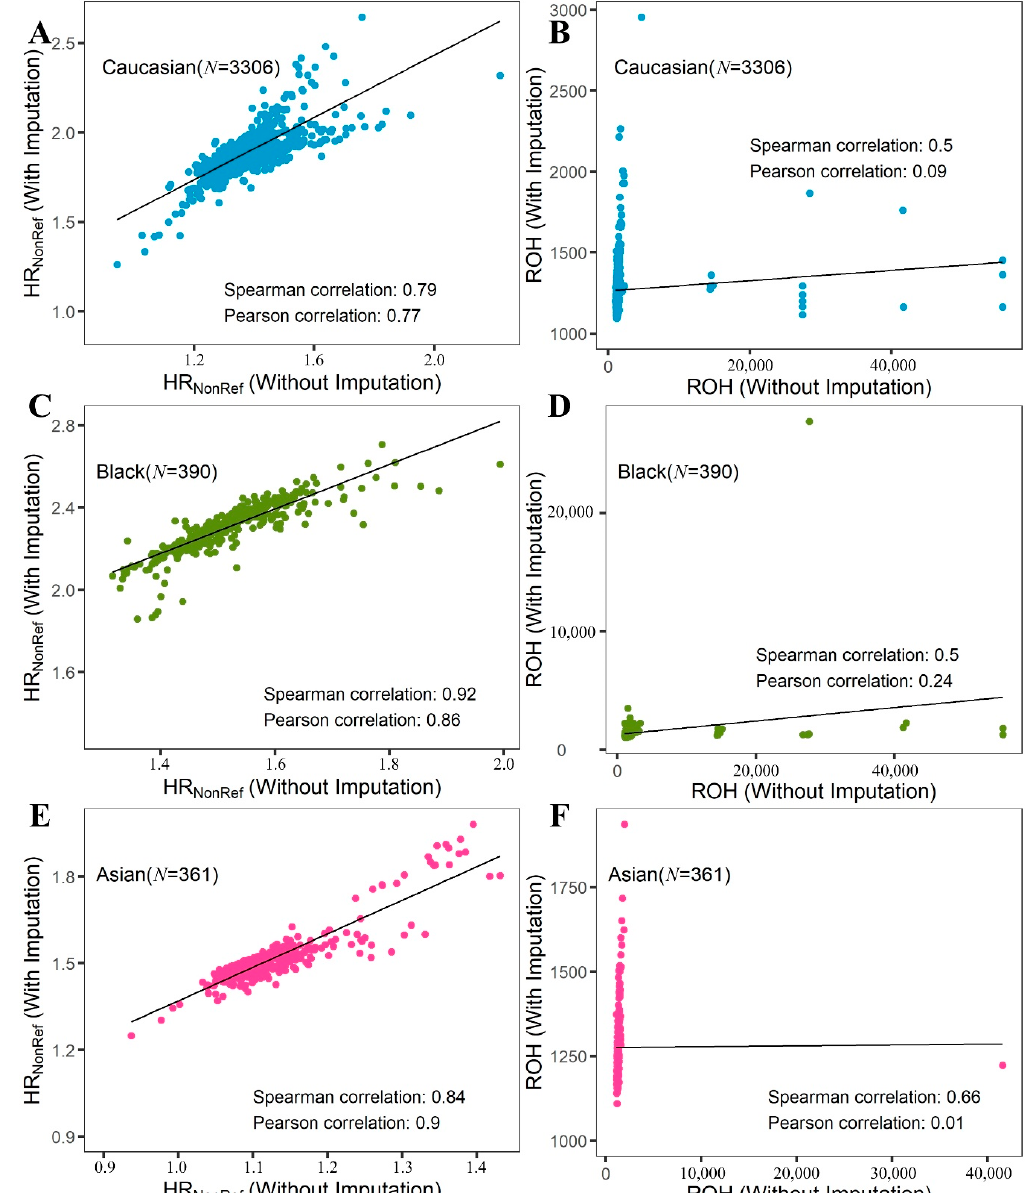
Figure 2. Scatter plot for HR NonRef , Runs of Homozygosity (ROH), before and after imputation. ( A , B ): Caucasian; ( C , D ): Black; ( E , F ): Asian. ( A , C , E ): HR NonRef ; ( B , D , F ): ROH. The correlations for ROH are weaker than HR NonRef before and after imputation due to the ROH outliers resulted from imputation. This shows that HR is less prone to the effect of SNP density than ROH.